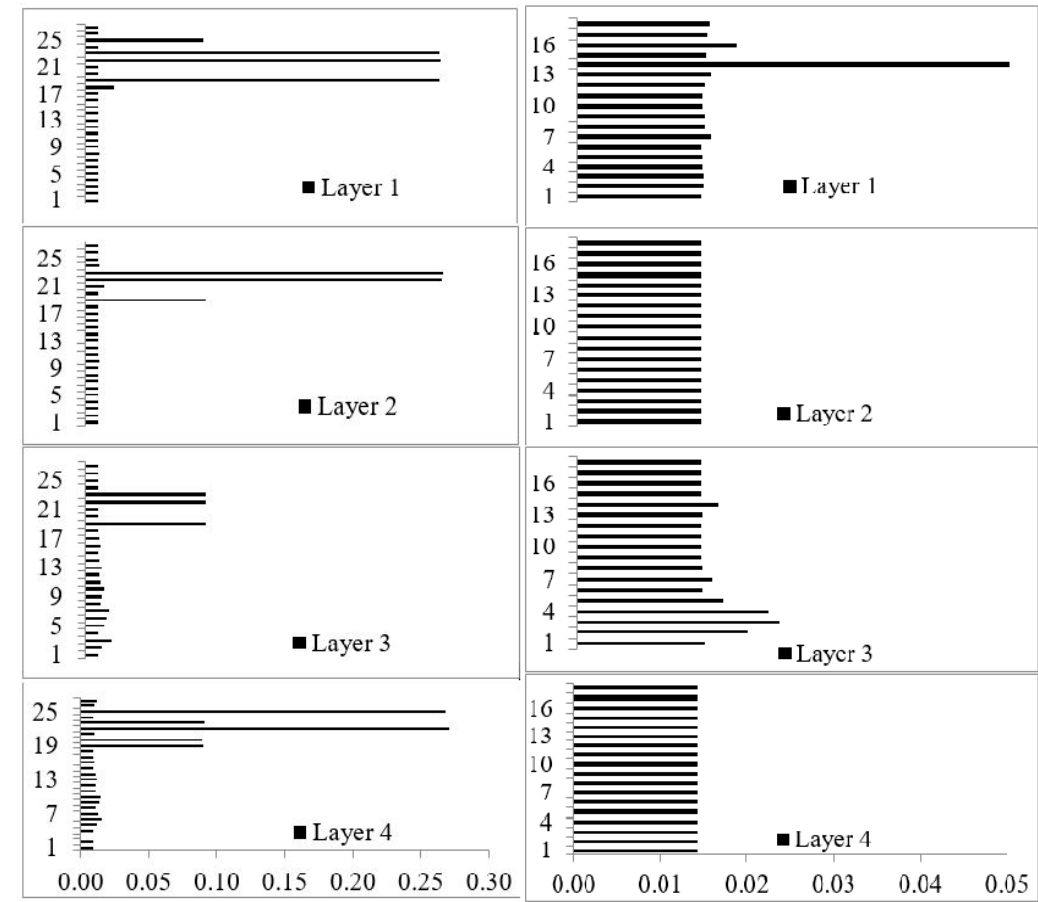
Figure 10. Sensitivity with regard to hydraulic conductivity and effective porosity for selected pilot points in different model layers. (Please note different scales for both plots).